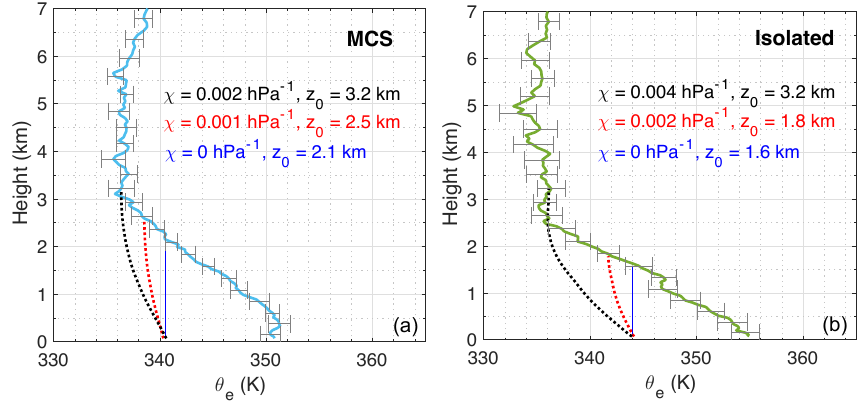
Figure 3. Mean profiles of θ e within 6h leading the passage of a deep convective event for MCSs (16 profiles; a ) and isolated cells (11 profiles; b ). Dashed lines indicate the mean descent path for plumes originating at various altitudes and mixing with the environment at various rates; solid blue line shows mean descent without mixing. Error bars are ± 1 standard error.